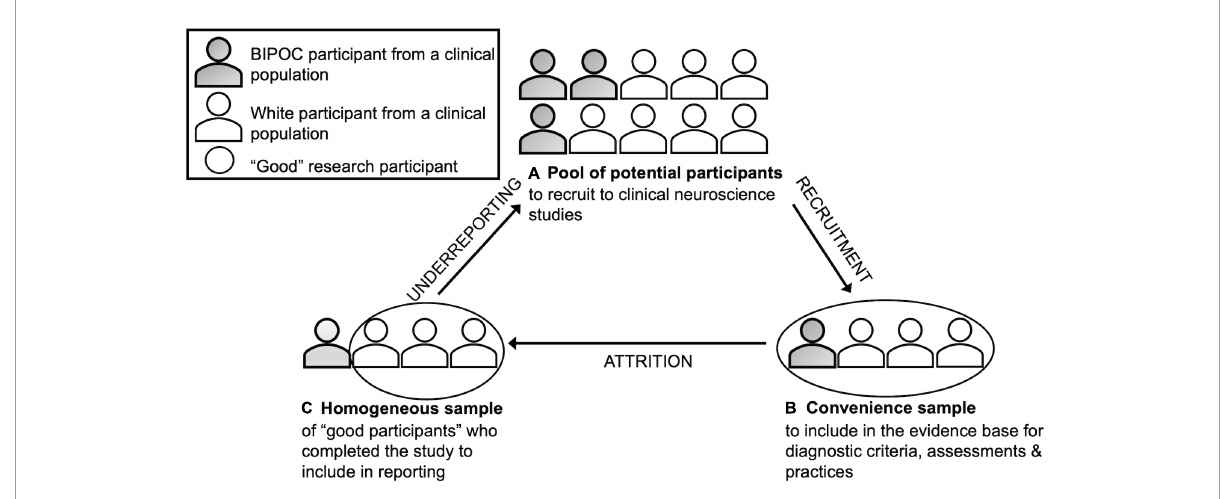
FIGURE1 Application of Dis/ability Studies and Critical Race Theory (Annamma et al., 2018) to clinical neuroscience.